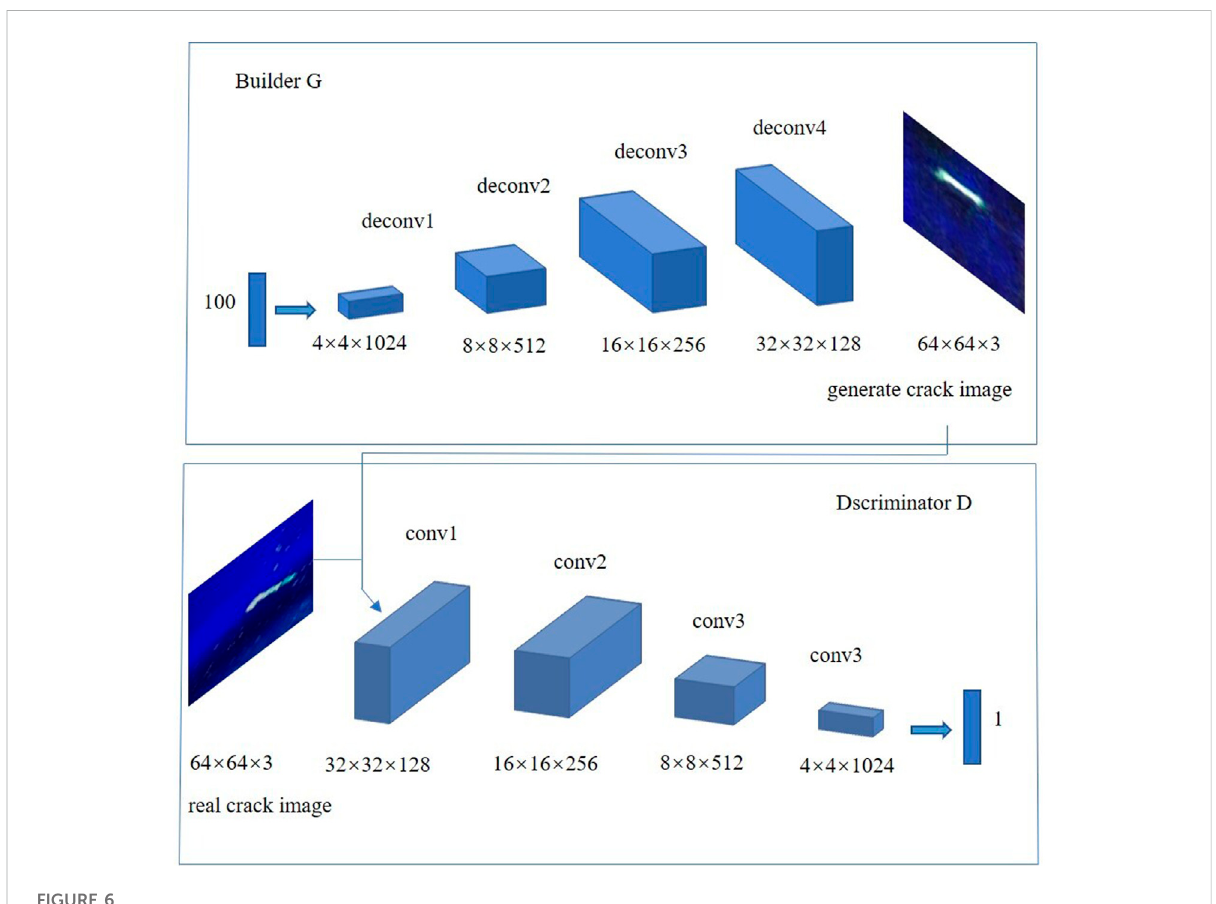
FIGURE 6 DCGAN crack generation network